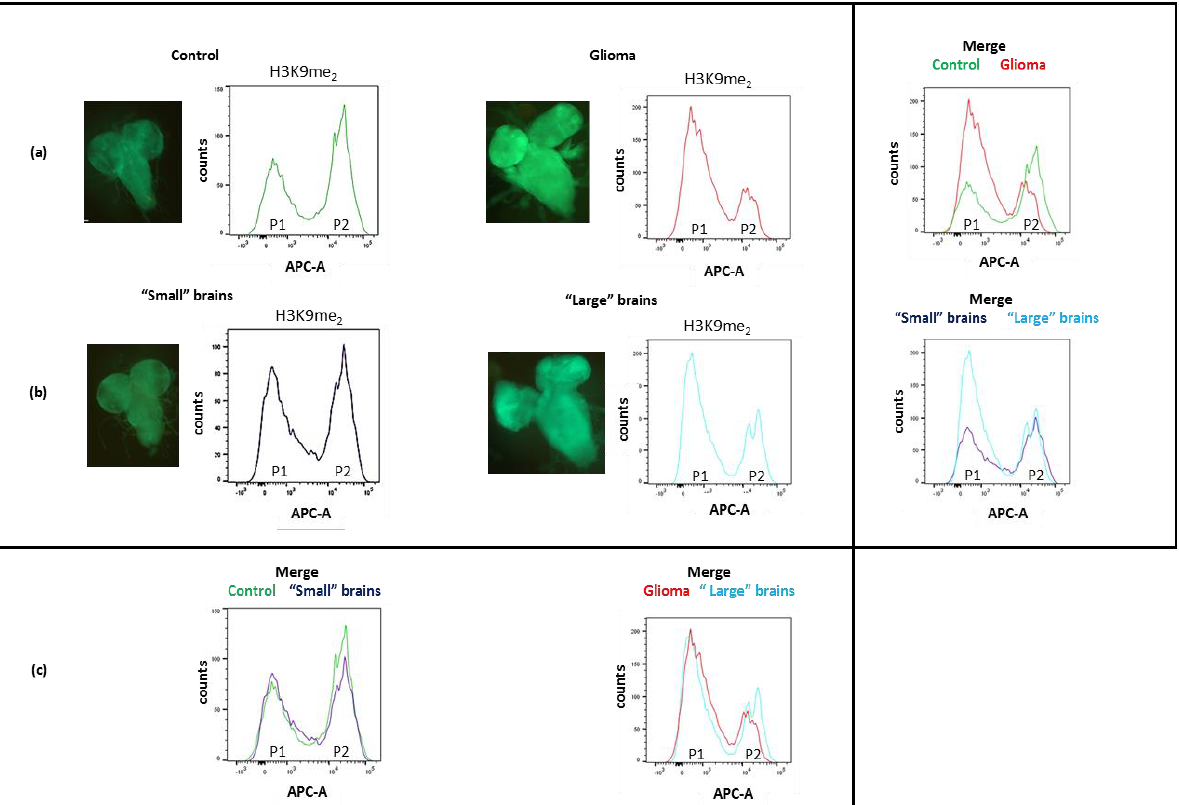
Figure 8. Analysis of H3K9me2 by flow cytometry in glial cells (with GFP expression). Pattern of H3K9me 2 in glial cells is shown for controls (repo>GFP), glioma (repo>dp110 CAAX ; dEGFRλ), “small” and “large” brains (repo>dp110 CAAX ; h5-HT7R; dEGFR λ ). Two populations of glial cells P1 and P2 differing by their methylation rate have been identified. ( a ) Comparison between controls and glio- mas. ( b ) Comparison between “small” and “large” brains. ( c ) Comparison between “small” brains and controls and between “large” brains and gliomas.